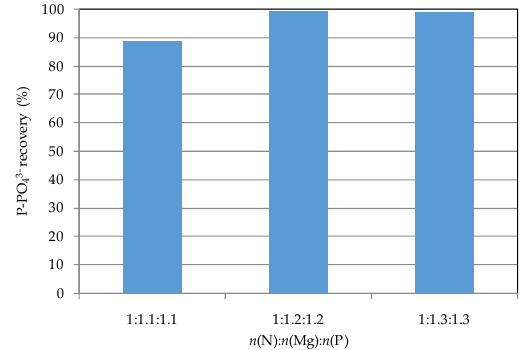
Figure 4. Phosphorus recovery during the tests conducted with the simultaneous dosage of reagents.